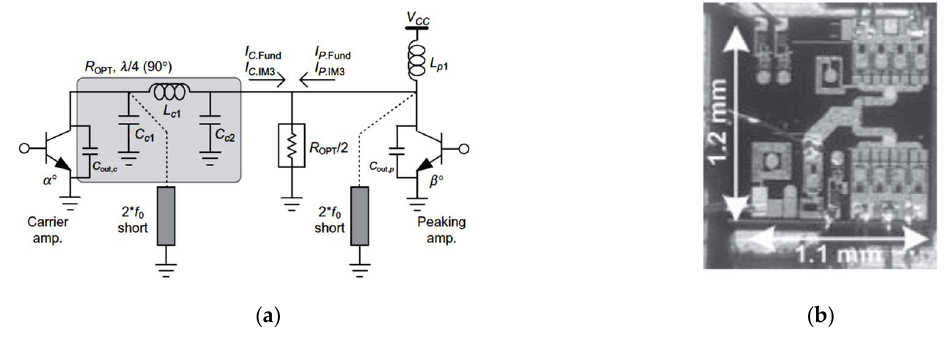
Figure 24. ( a ) Doherty amplifier using a lumped low-pass π -type quarter-wave inverter. ( b ) Picture of fabricated DPA using an InGaP/GaAs HBT described in [128].